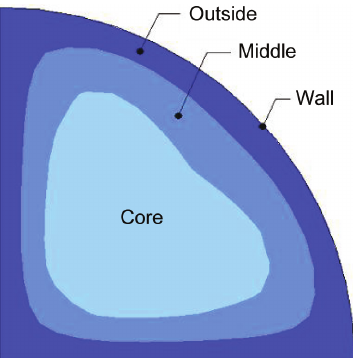
Fig. A1. Schematic representation of layers used in model sim- ulations to assess the influence of radial temperature and velocity gradients in the flow